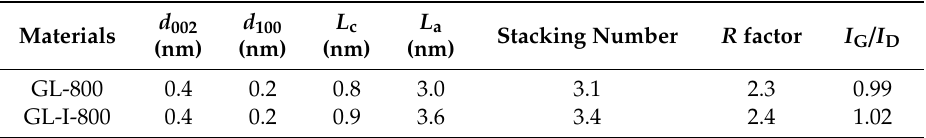
Table 2. Crystal structure of GL-800 and GL-I-800: interlayer space, L c , L a , stacking number, R factor, and I G / I D